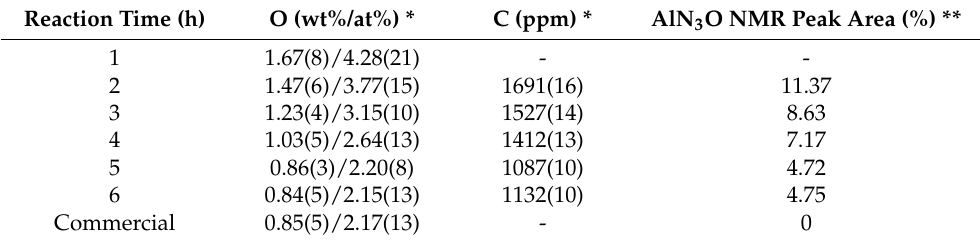
Figure 1. XRD patterns of the products obtained at different reaction times at 1700 °C. Table 1. Oxygen concentration of AlN samples after decarbonization.